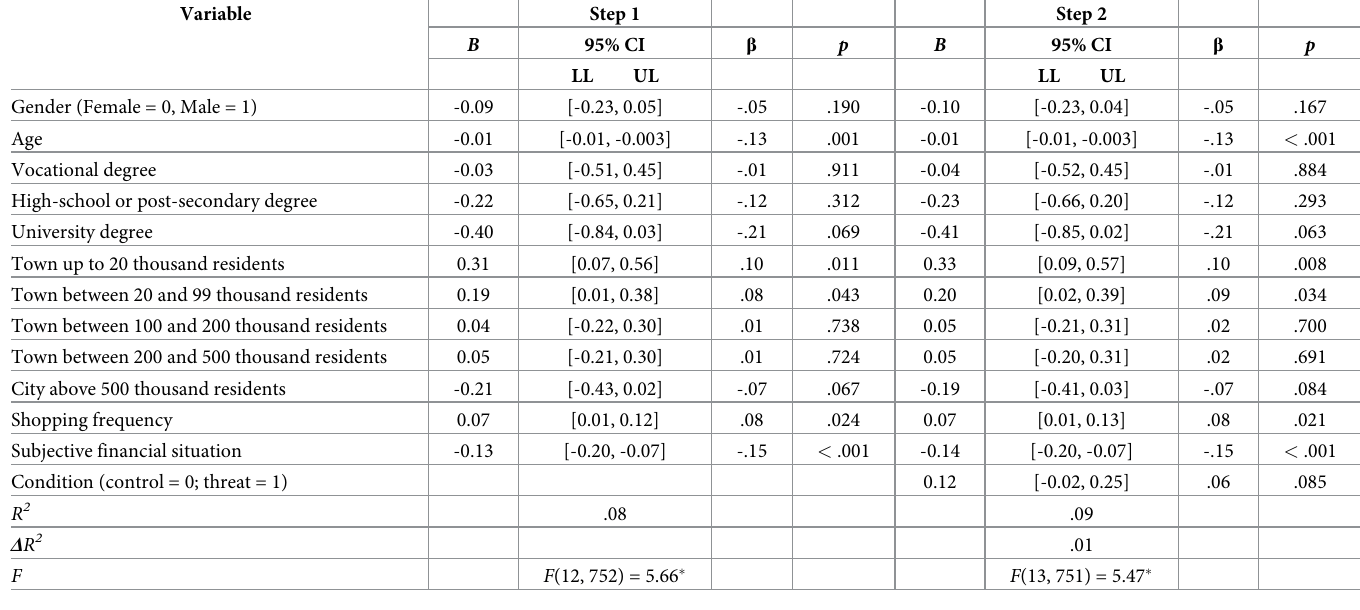
Table 5. Predictors of general conspiracy beliefs (Study